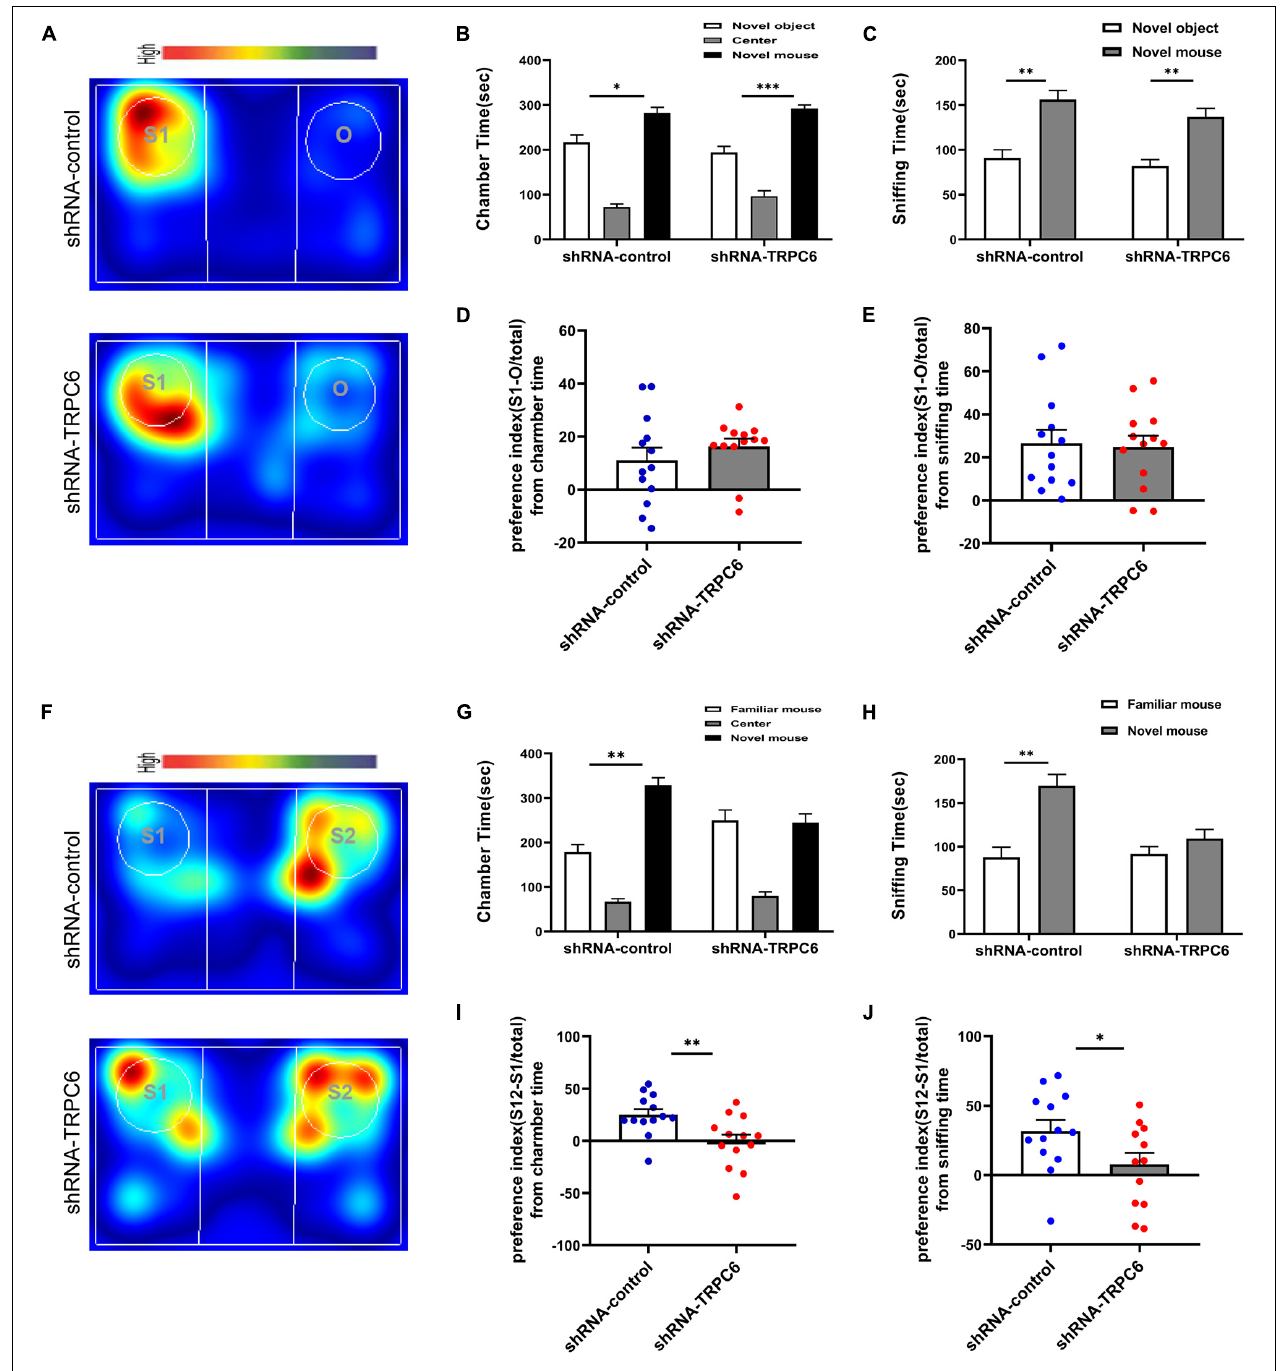
FIGURE 4 | Reduced expression of TRPC6 caused impaired social memory but does not affect social function in mice. (A,F) Representative heat maps showing the total time and location of during the 10-min social approach task (A) and social novelty recognition (F) . Warmer colors (red) indicate longer time the mice spend exploring. “O” and “S1” represent object and novel mouse, “S1” and “S2” represent familiar mouse and novel mouse, respectively. (B,C) There was no difference between the two groups of mice in terms of chamber time and sniffing time. (D) Preference index (S-O/total) in chamber time. (E) Preference index (S-O/total) in sniffing time. (G,H) Control mice exhibited a significant preference for novel mouse compared with the familiar mouse, whereas mice injected with shRNA-TRPC6 exhibited a characteristic lack of social novelty as demonstrated by approximately equal amounts of time with the novel mouse and familiar mouse. (I) Preference index (S2-S1/total) in chamber time. (J) Preference index (S2-S1/total) in sniffing time. Sample sizes for each group: n = 13. Data were presented as mean ± SEM. * p < 0.05, ** p < 0.01, *** p < 0.001.